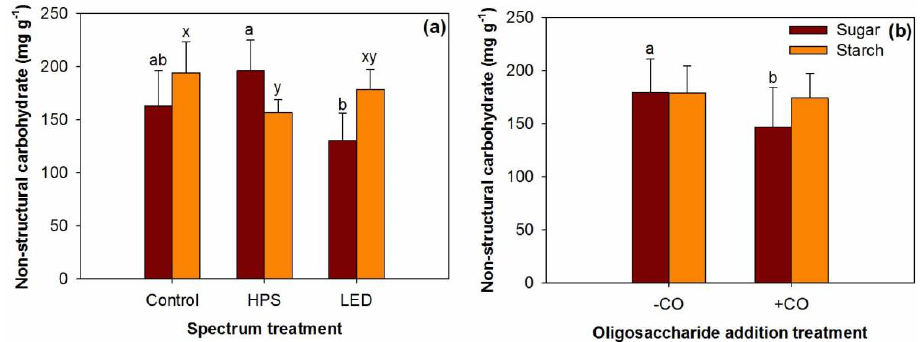
Figure 4. Concentrations of soluble sugars and starch in the stem of Fragrant rosewood ( D. odorifera ) seedlings cultured in the main effects of lighting spectra ( a ) and chitosan oligosaccharide addition ( b ). Ctrl, the control of the natural illumination; HPS, high-pressure sodium; LED, light-emitting diodes; −CO, the treatment without chitosan oligosaccharide addition; +CO, the treatment with chitosan oligosaccharide addition. Different letters indicate significant differences at the 0.05 level. Letters of a and b for sugar and those of x and y for starch.